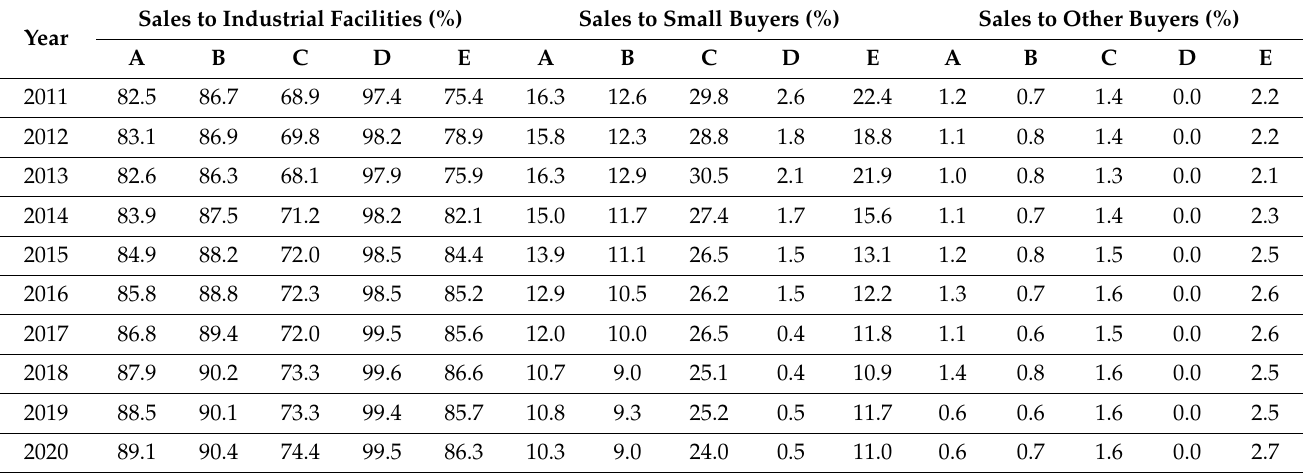
Table 3. Direction of timber sales by buyer group